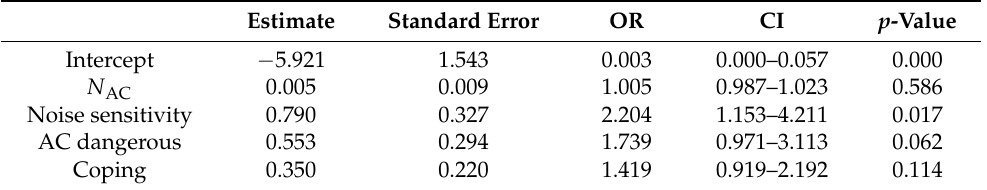
Table 5. Multiple logistic regression model LR3 with random effects for the prediction of aircraft noise-induced short-term annoyance at night of children. Acoustical variable: N AC during time in bed . Adjusted Odds Ratios (OR) with 95% Confidence Intervals (CI) and p -values, AIC = 661.